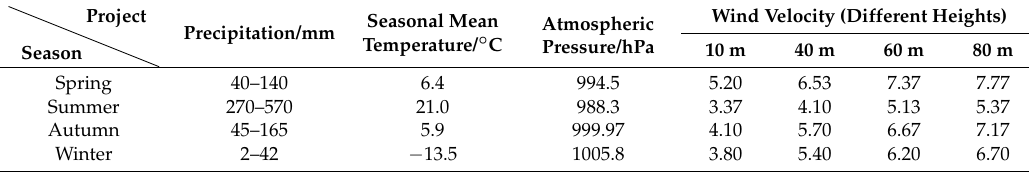
Table 3. Characteristics of the four